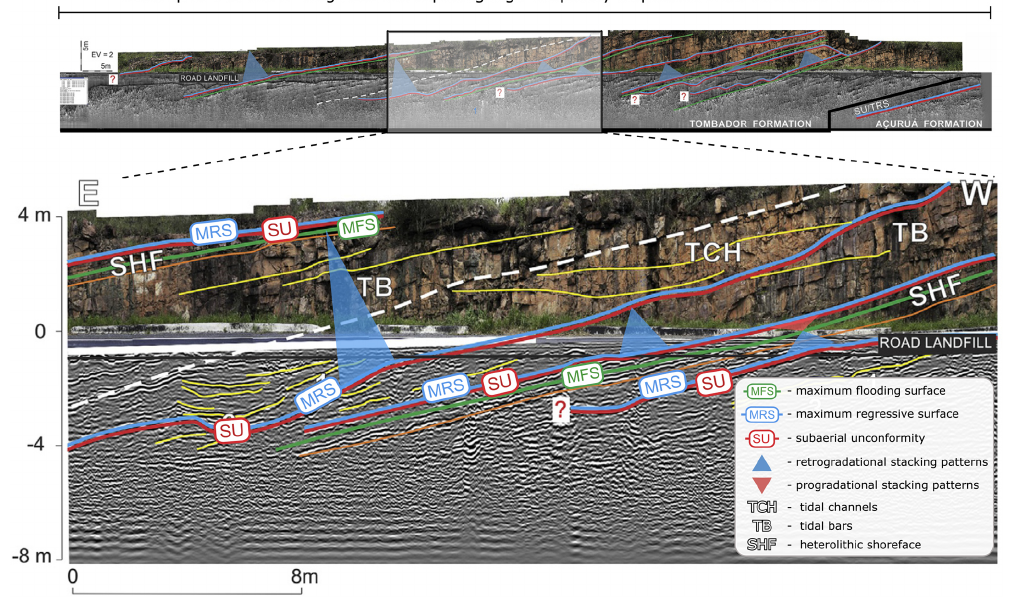
Figure 25. High-frequency sequences identified in an outcrop and in a ground-penetrating radar (GPR) profile of the Tombador Formation (Mesoproterozoic), Chapada Diamantina region, Brazil (modified from Magalhães et al., 2017). The sequences are composed of tidal chan- nels and bars, bounded at the top by heterolithic intervals that configure cycles of retrogradational stacking patterns defined by the recurrence of the same type of stratigraphic surface in the geological